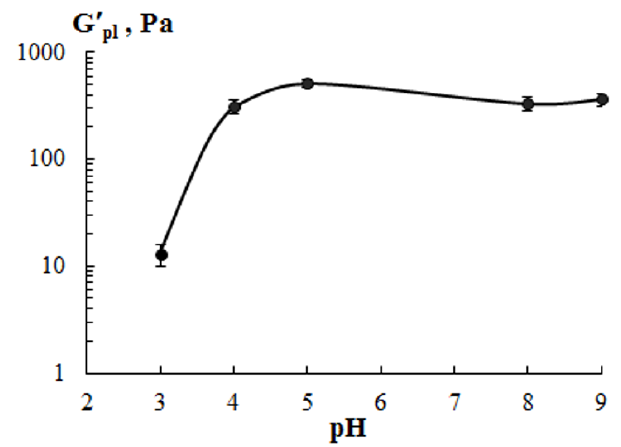
Figure 8. E ff ect of extraction conditions on the storage modulus plateau (G (cid:48) pl ) for cod gelatin gels. C G = 10 wt.%.